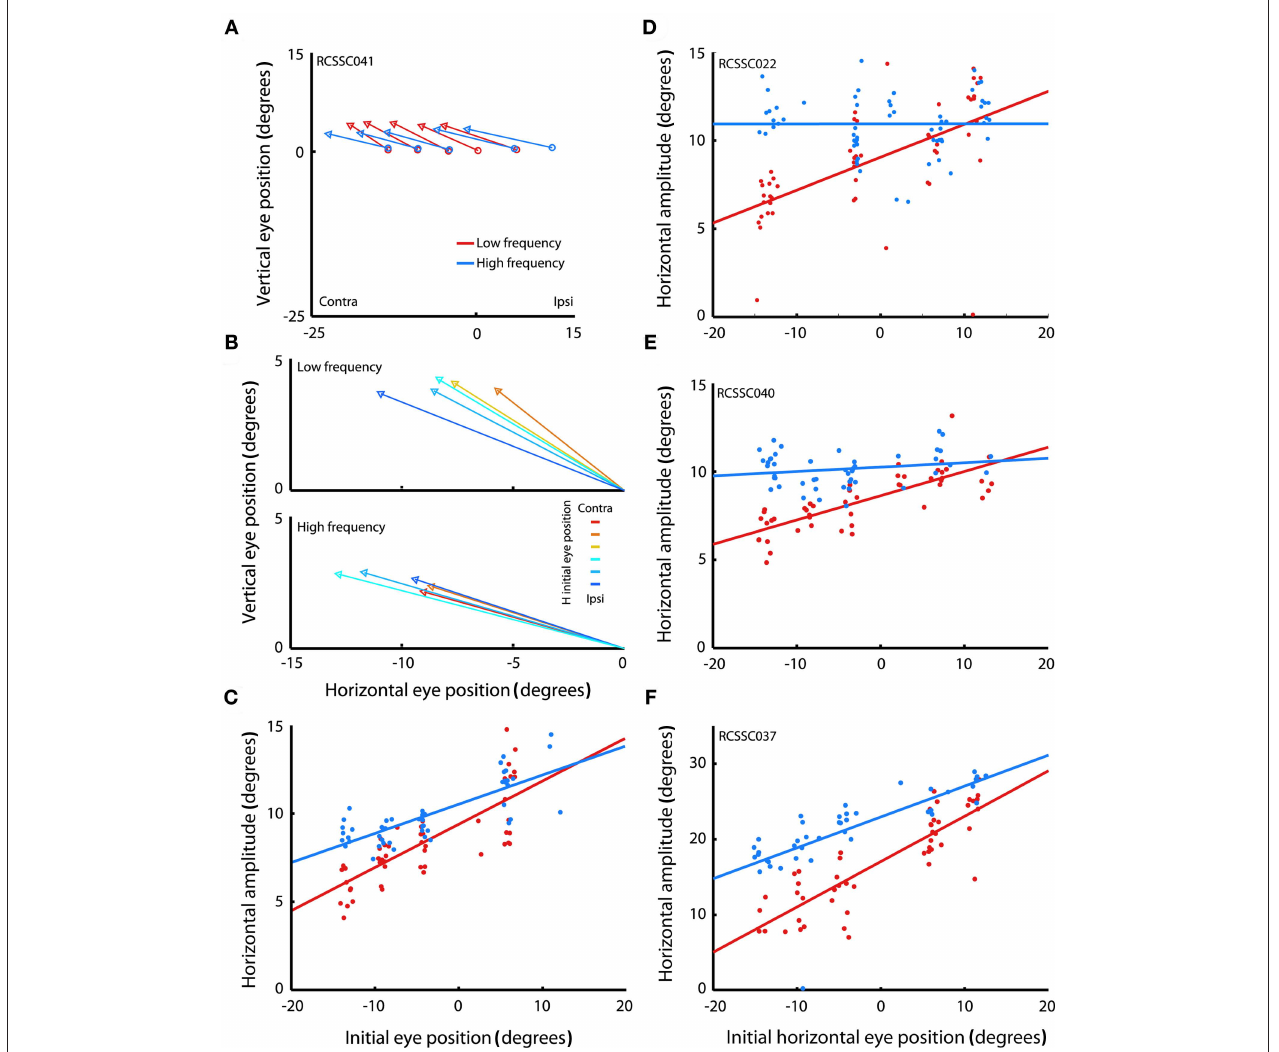
shown in (A) . Saccade vectors are aligned on a common origin to highlight the differences in vector as a function of initial eye position (indicated by color). Saccades evoked by both high- and low frequency stimulation showed an effect of initial eye position, but the effect was larger for low frequency stimulation. (C) Amplitude of individual saccades evoked by low and high frequency microstimulation in the same site as shown in (A,B) , as a function of initial eye position. Lines show linear regression through the data. Each data point represents a single saccade (D–F) . Same as (C) , for three additional sites. The low frequency regression fits are significant for all sites illustrated ( p < 0.0001); the high frequency regression fits are significant in (C,F) ( p <